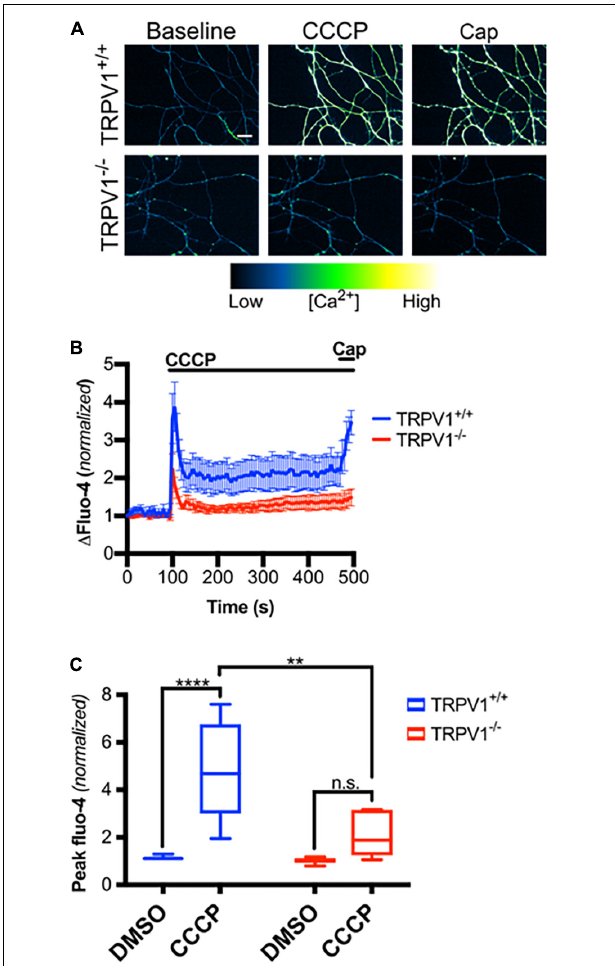
FIGURE 7 | Mitochondrial depolarization in axons causes calcium influx through TRPV1. (A) trpv1 + / + and trpv1 – / – axons loaded with Fluo-4-AM and treated with CCCP (50 µ M; t = 100 s) then capsaicin (Cap, 1 µ M; t = 475 s; scale bar indicates 25 µ m). (B) Changes in Fluo-4 intensity after CCCP treatment and after Cap treatment, normalized to intensities at t = 0 s ( n = 6 for each group). Values are mean ± SEM. (C) Peak Fluo-4-AM intensities immediately following CCCP treatment (taken from panel B ) normalized to fluorescence intensities at t = 0 s for each group. Boxplots are minimum, 1st quartile, median, 3rd quartile, maximum. Statistical significance was assessed using a two-factor ANOVA followed by Tukey’s post hoc comparison panel (C) , ** p < 0.01, **** p <